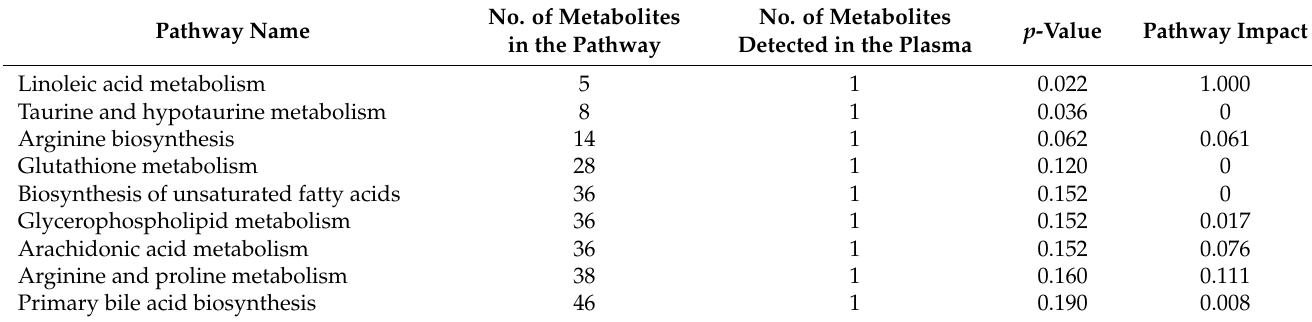
Table 5. Metabolic pathways corresponding to significant metabolites identified in plasma samples with